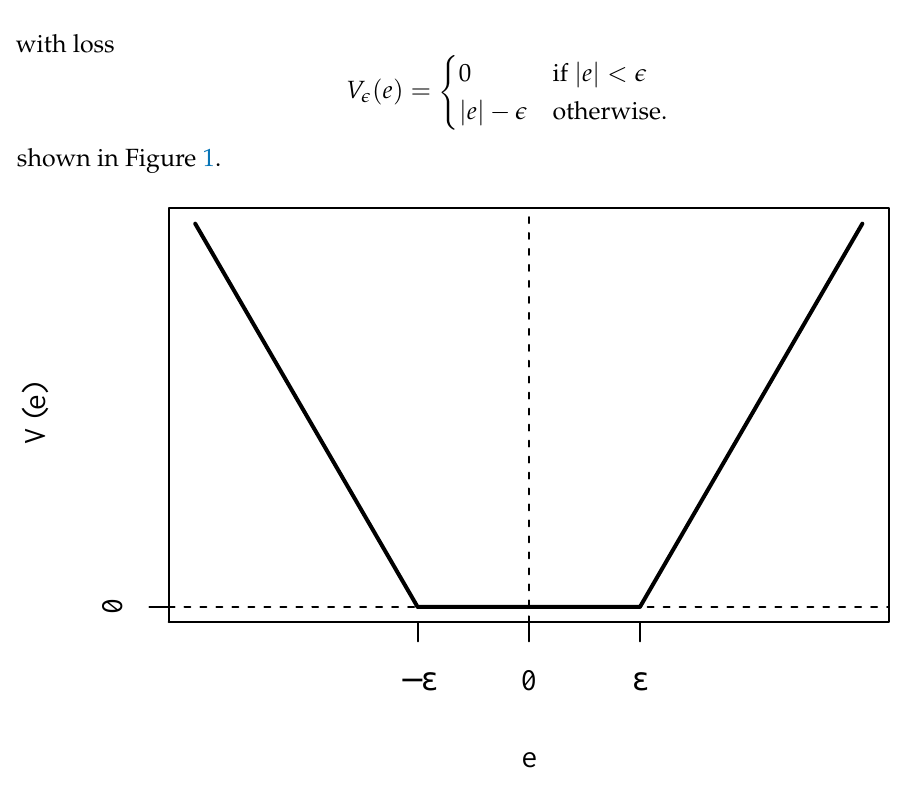
Figure 1. (cid:101) -intensive loss